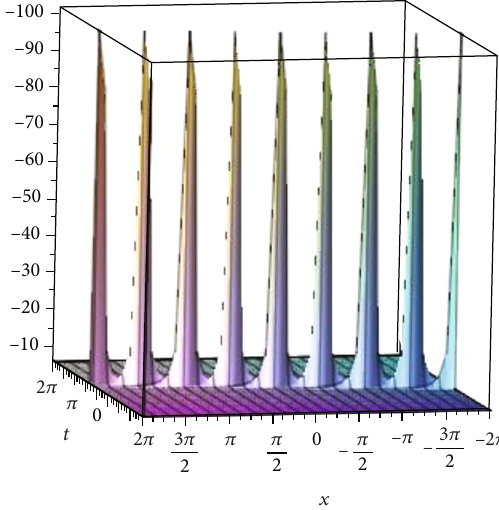
ð z Þ for the fi xed r ,2 Figure 7: Perspective view of 3D graph of W values ω = 6 , z 0 = 1/8 , μ = 1 , k = 1 , s = 1 , e = 1 , and α = 1 represents exact solutions.